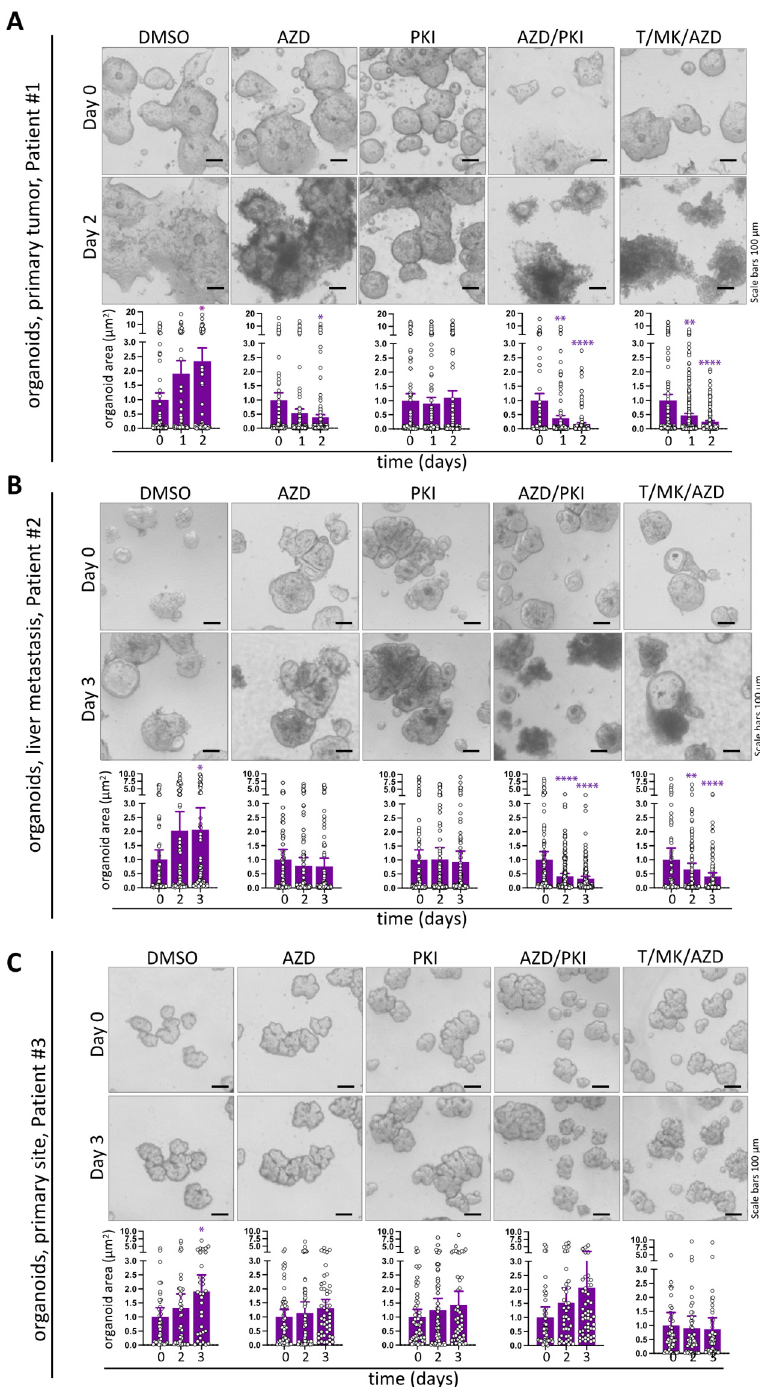
Figure 5. Impact of single and combined PKI-587 and AZD treatment on organoids in comparison to T/MK/AZD treatment. ( A ) Representative phase contrast images of a primary human organoids for 48 h with (combi)inhibitors. The size of every individual organoid present in three microscopic frames was determined over time and plotted (dots). Bars represent mean organoid projected area over time. Error bars show SEM. ( B ) Images and mean organoid size of human colon cancer organoids derived from liver metastasis treated and analyzed as in ( A ). ( C ) Images and mean organoid size of colon cancer organoids from a primary colon cancer of a different patient treated and analyzed as in ( A ). Significant changes to the corresponding d0 time points are indicated. p- values are shown (asterisks, purple). Non-significant changes were not labeled.